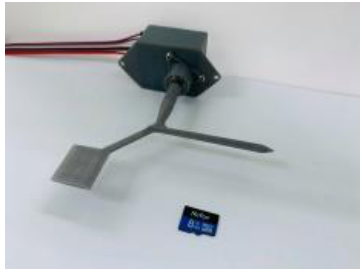
Figure 3. AOA sensor.